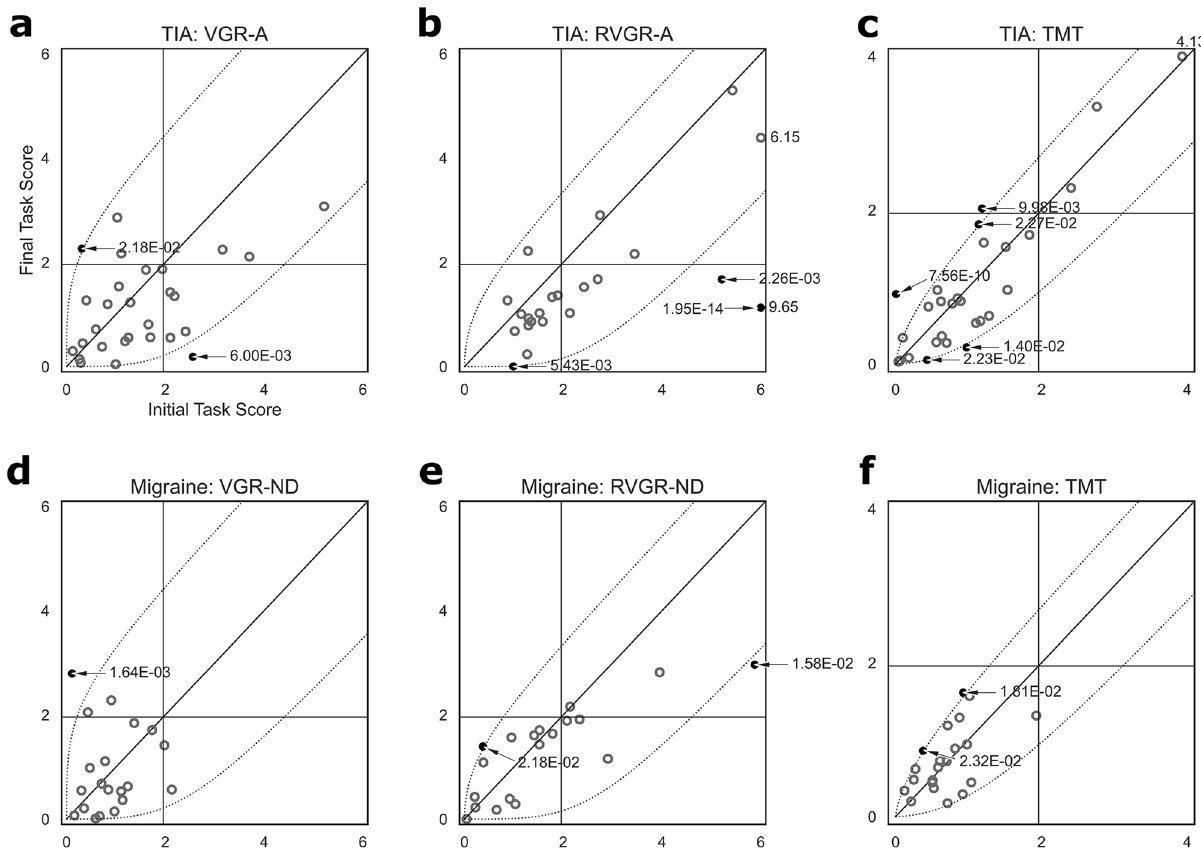
Figure 2. Scatterplots of one-sided Task Scores at first- and second assessments in TIA ( a – c ) and migraine ( d – f ) cohorts. All: Horizontal and vertical dashed lines indicate impairment thresholds (1.96); diagonal lines indicate unity. Curved dashed lines indicate thresholds of significant change based on the expected change of healthy control participants, accounting for learning effects in RVGR-A/RVGR-ND and TM only. Values > 6 (VGR-A/VGR-ND, RVGR-A/RVGR-ND) or > 4 (TM) are marked on the plots (no arrows pointing at relevant datapoints). Individual significant change p-values are marked when changes were significant (arrows pointing at relevant datapoints). Open darker circles represent non-significant changes (i.e., within the curved boundaries), whereas filled circles represent significant changes (i.e., outside the curved boundaries). ( a – c ) Plots for TIA. ( d – f ) Plots for